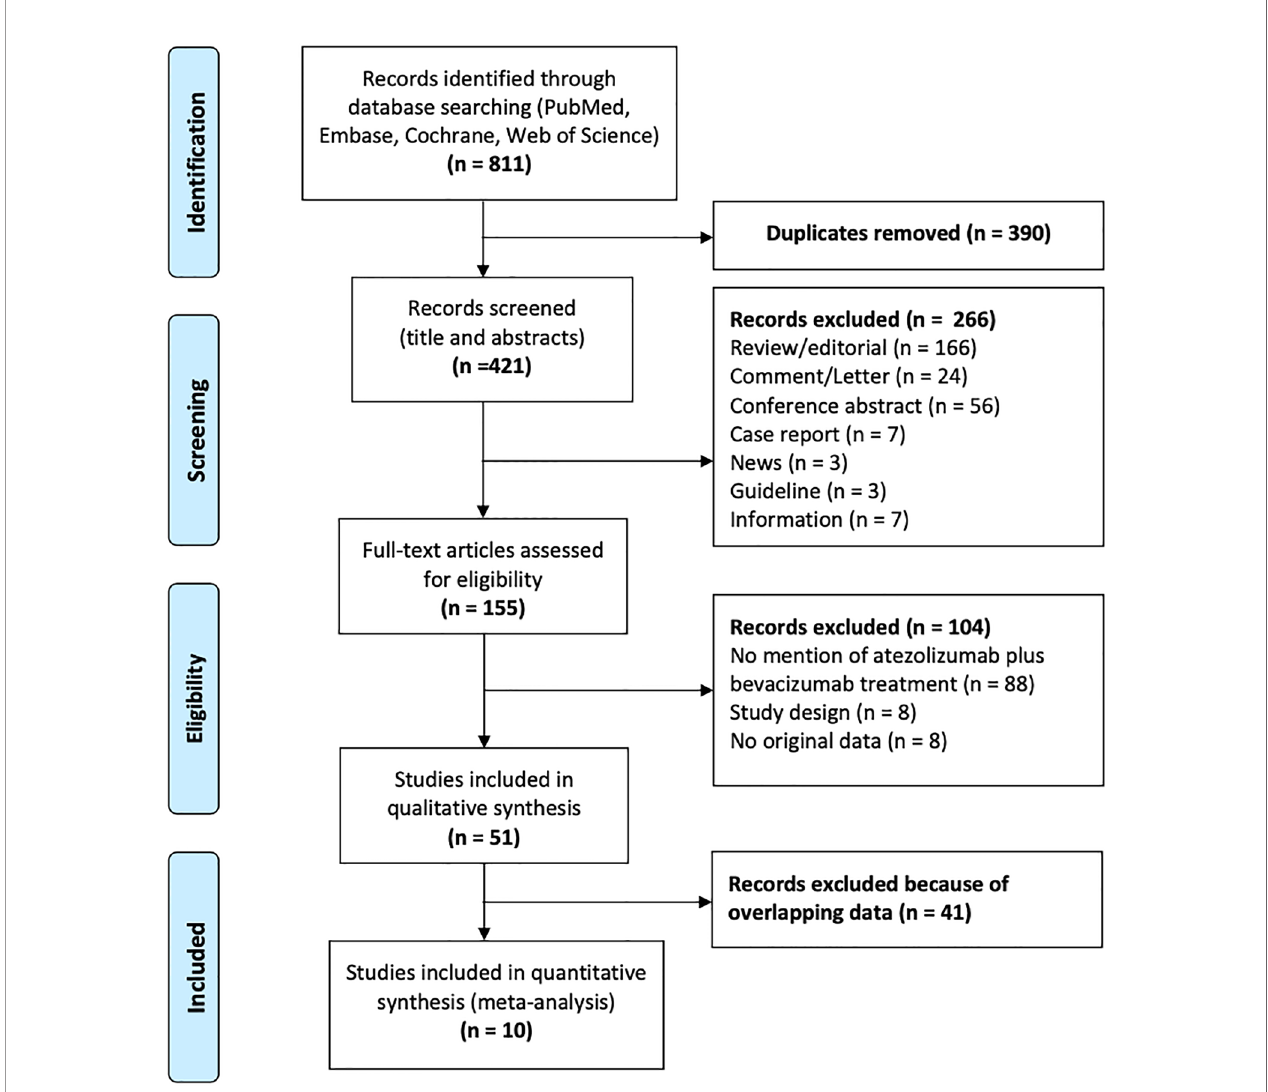
FIGURE 1 | Flow chart of the selection of publications included in the